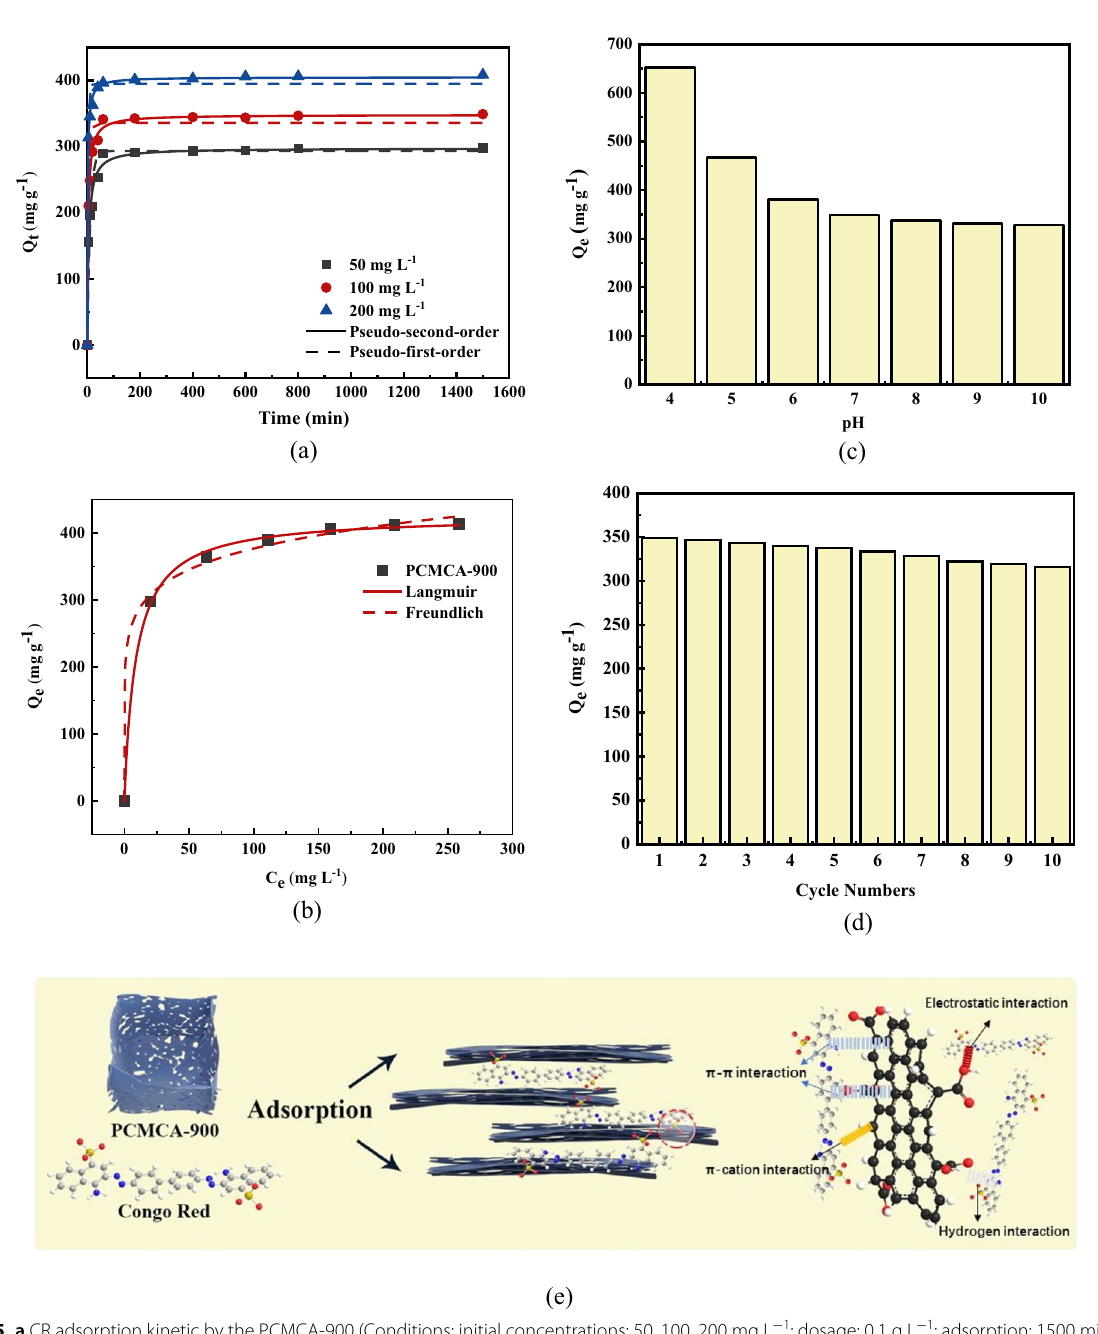
Fig. 5 a CR adsorption kinetic by the PCMCA-900 (Conditions: initial concentrations: 50, 100, 200 mg L − 1 ; dosage: 0.1 g L − 1 ; adsorption: 1500 min; temperature: 35 °C). b Adsorption isotherms of CR at 35 °C by PCMCA-900 (Conditions: initial concentrations: 50 to 300 mg L − 1 ; dosage: 0.1 g L − 1 ; temperature: 35 °C). c Effect of pH values on the CR adsorption capacity of PCMCA-900 (Conditions: initial concentrations: 100 mg L − 1 ; dosage: 0.1 g L − 1 ; temperature: 35 °C). d recyclability of PCMCA-900. e adsorption scheme for CR of the